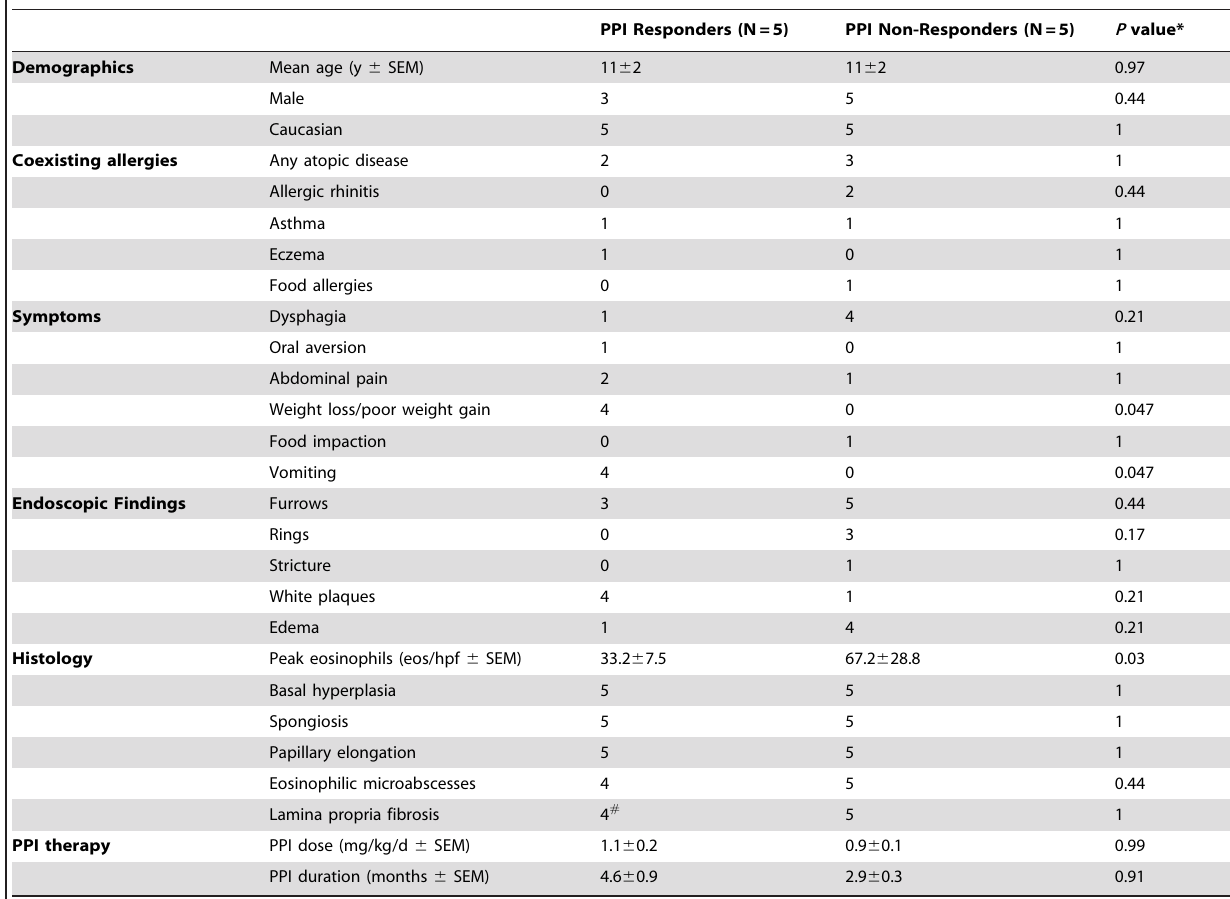
Table 1. Baseline Patient